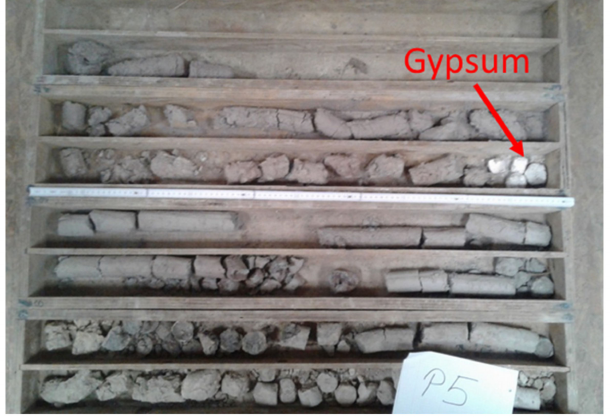
Figure 5. Gypsum interlayer in the core records of borehole No